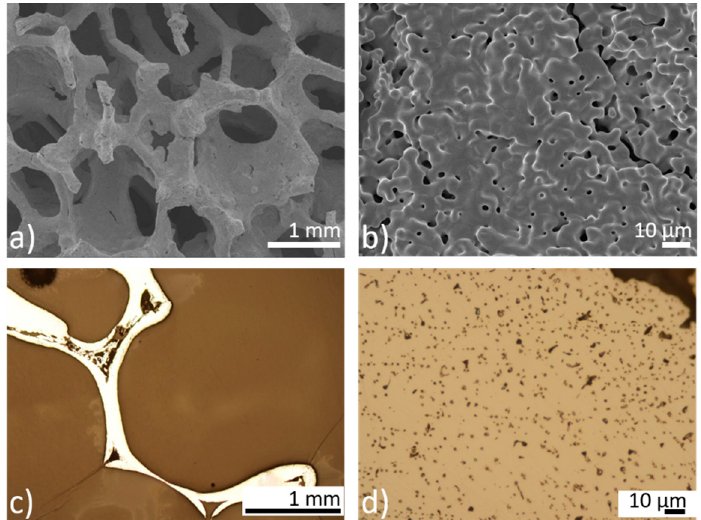
Figure 1. ( a , b ) The scanning electron microscopy (SEM) micrographs of the sintered iron scaffold; ( c , d ) metallographic cross-sections of the sintered iron scaffold. Comparison of the different porosities present in the material.